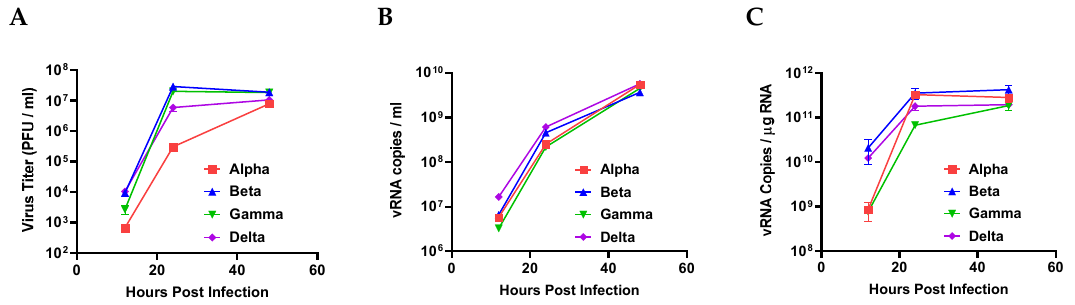
Figure 3. Viral replication rate of four SARS-CoV-2 variants. ( A ) The infectivity of the progeny viruses was evaluated via plaque forming assay completed at 12, 24, and 48 h post infection. ( B ) Extracellular and ( C ) intracellular viral RNA were assessed by qRT-PCR with SARS-CoV-2 NP probes. All error bars indicate the standard errors of the